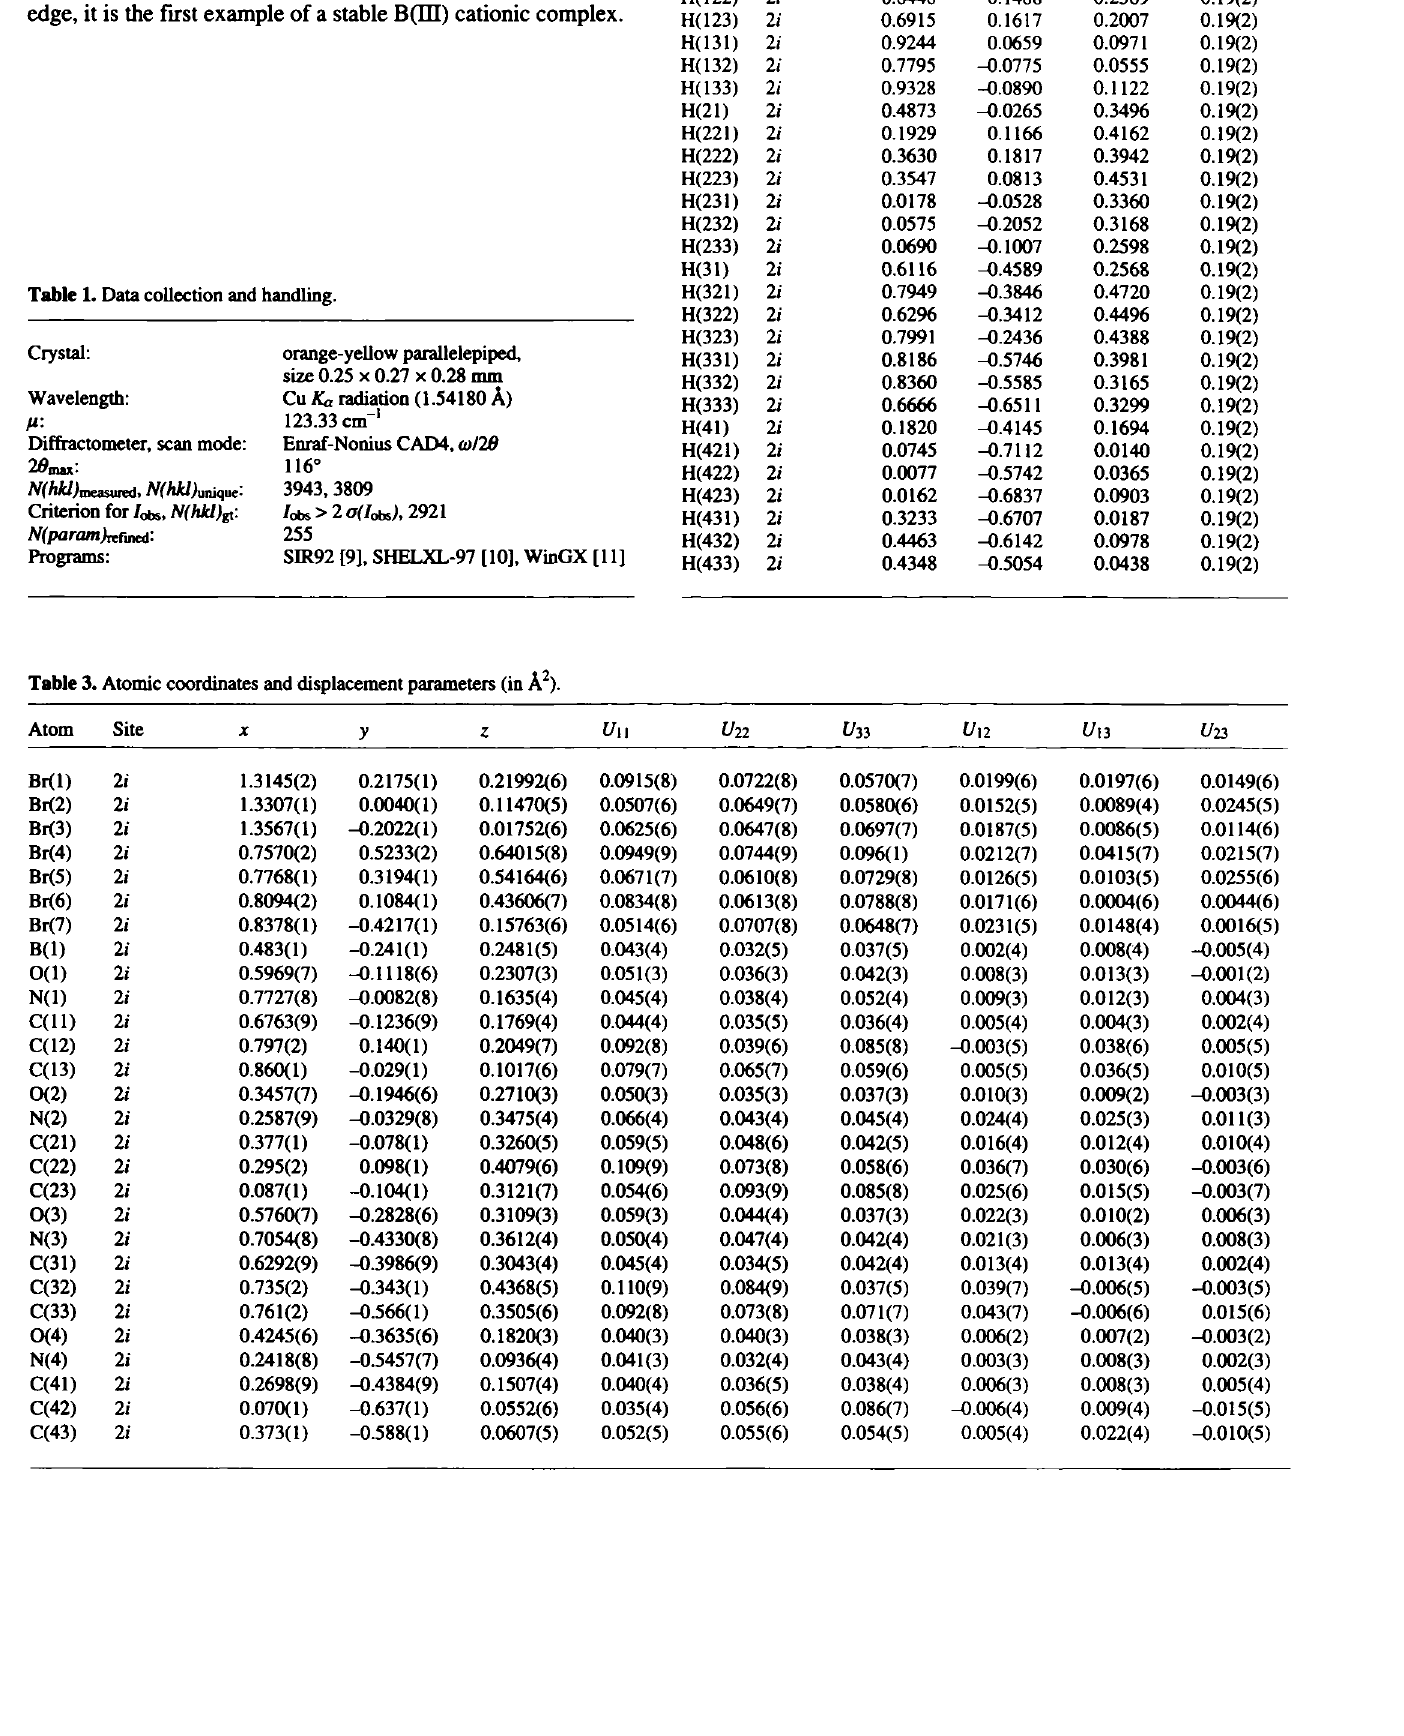
Table 1. Data collection and handling.